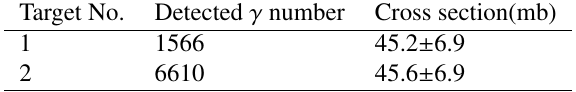
Figure 5. Excitation curve for 9.17MeV γ ray from the reaction 13 C(p, γ ) 14 N.